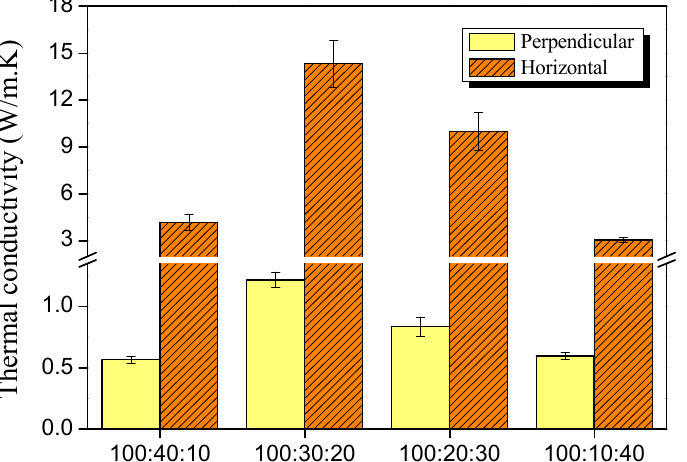
Figure 2. Perpendicular and horizontal thermal conductivity of the composites with different mixing ratios of polypropylene:carbon fibers:graphite